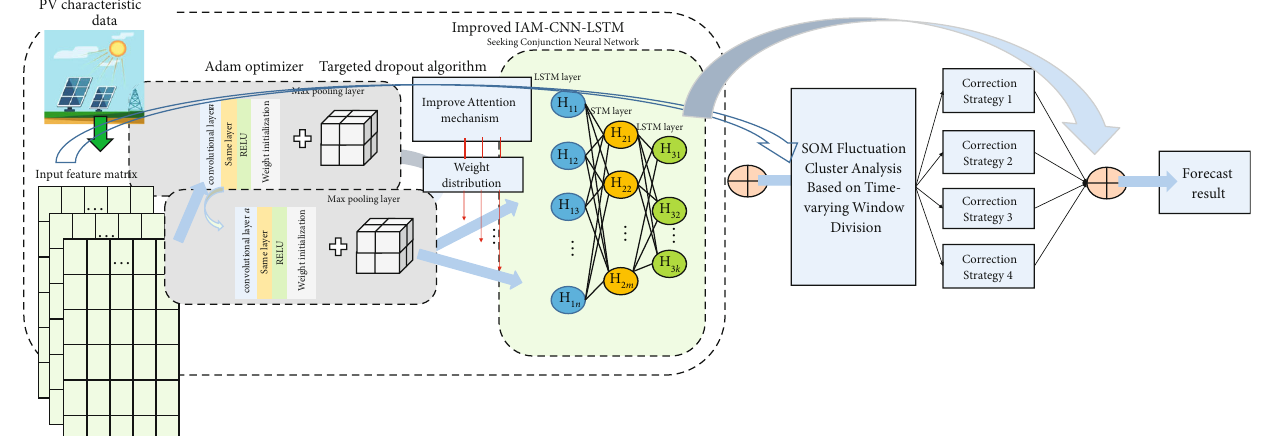
Figure 15: Block diagram of data structure.